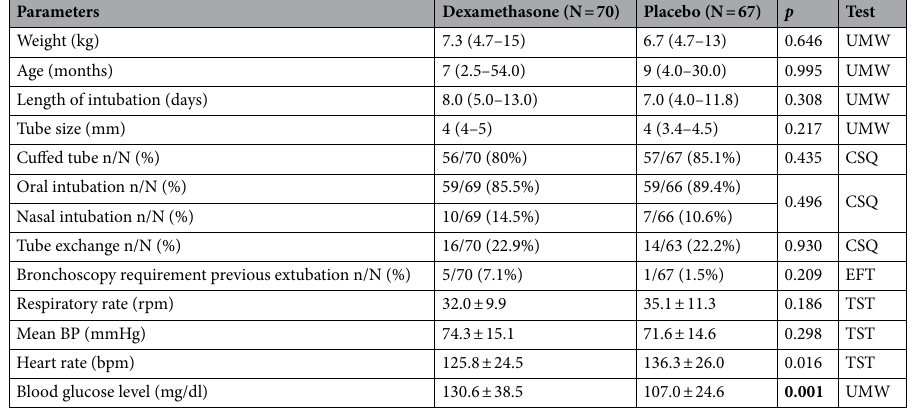
Table 1. Patients’ baseline data prior to extubation (mean and standard deviation, median and interquartile range or number and percentage). Chi-squared test (CSQ), Exact Fisher Test (EFT), T -student test (TST) or U-Mann Whitney (UMW) test was used. Data regarding intubation approach (oral or nasal) was missed in 2 patients and data regarding requirement of bronchoscopy prior to extubation was missed in 4 patients. Statistically significant values appear in bold.